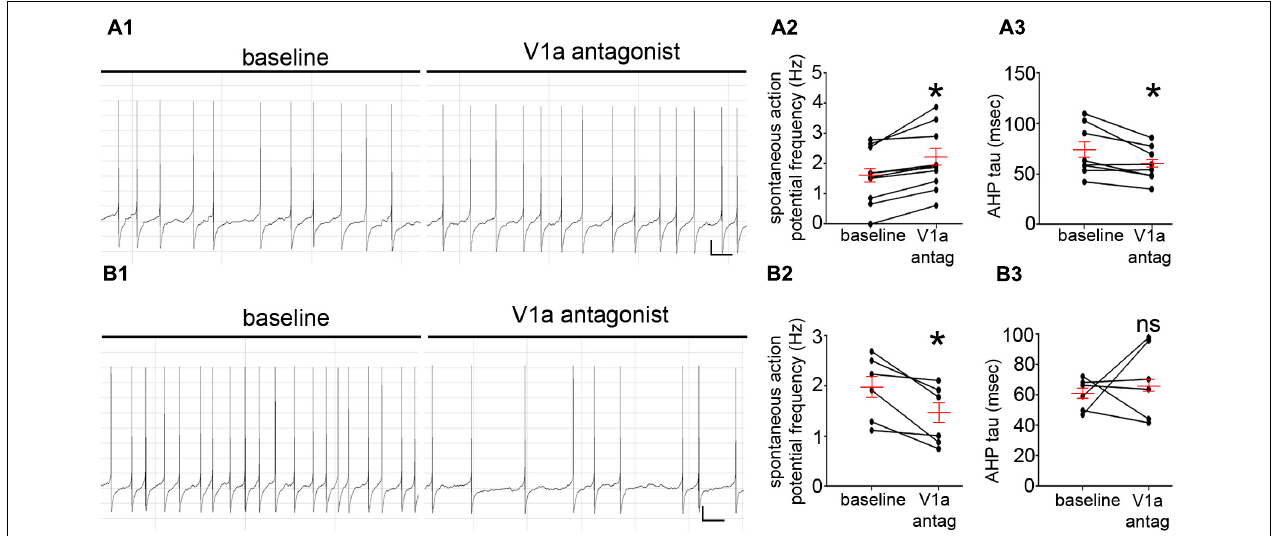
FIGURE 5 | V1a receptor modulation directly alters LC noradrenergic neuronal activity. (A1) Representative traces of the spontaneous firing patterns of an LC neuron before and after the application of the V1a receptor antagonist [d(CH2)51, Tyr(Me)2, Arg8]-Vasopressin, 30 nM, from a cohort of neurons that responded with a significant increase in the frequency of spontaneous action potentials. (A2) Quantification of the spontaneous firing rates (Hz) of LC neurons before and after the application of the V1a receptor antagonist. (A3) Quantification of the afterhyperpolarization time constant (msec) of LC neurons before and after the application of the V1a receptor antagonist. (B1) Representative traces of the spontaneous firing patterns of an LC neuron before and after the application of the V1a receptor antagonist, from a cohort of neurons that responded with a significant decrease in the frequency of spontaneous action potentials. (B2) Quantification of the spontaneous firing rates (Hz) of LC neurons before and after the application of the V1a receptor antagonist. (B3) Quantification of the afterhyperpolarization time constant (msec) of LC neurons before and after the application of the V1a receptor antagonist. In the graphs, the dots represent the values for individual cells, the long red bars represents the mean for all cells within that group, and the short red bars represent the SEM. ∗ p < 0.05, paired Student’s t -test. Scale bars (A1,B1) horizontal bar 1 s, vertical bar 10